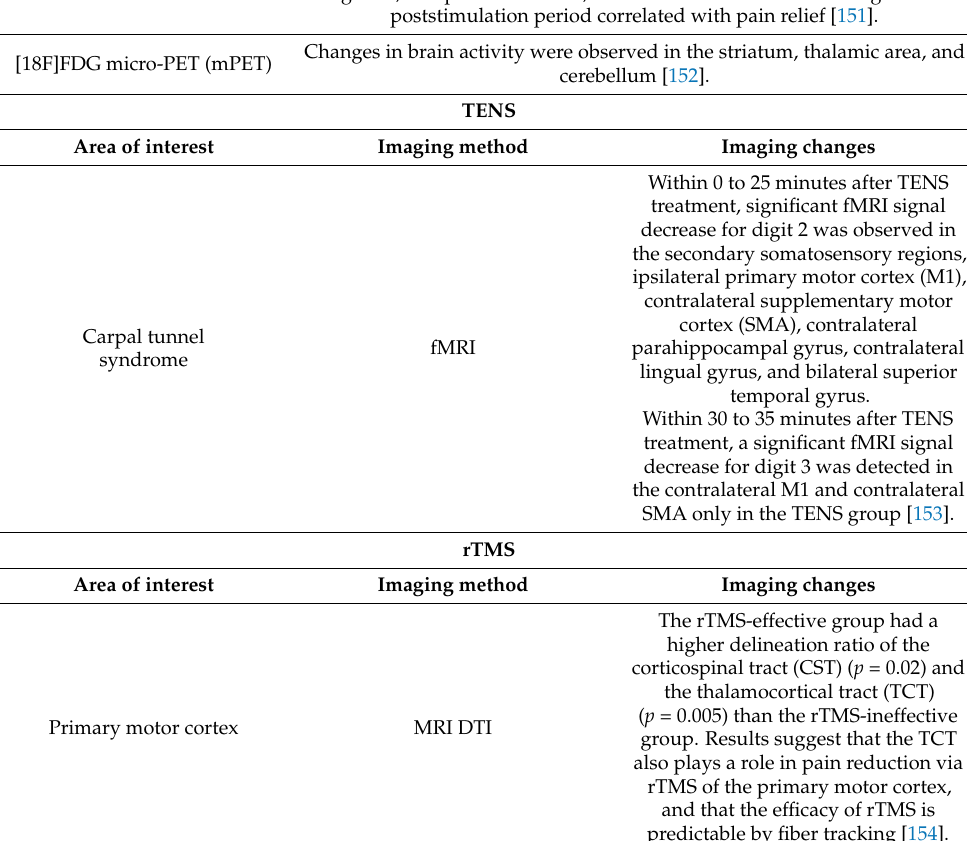
Table 2. Cont. Compared to baseline, turning on the stimulator was associated with CBF increase in the contralateral (anterior) midcingulate cortex (aMCC, BA24 and 32) and in the dorsolateral prefrontal (BA10) cortex. The most important changes in CBF were observed in the 75 min after discontinuation of MCS [15O]H2O PET (OFF). This poststimulation period was associated with CBF increases in a large set of cortical and subcortical regions (from posterior MCC (pMCC) to pregenual (pg) ACC, orbitofrontal cortex, putamen, thalami, posterior cingulate, and prefrontal areas, and in the brainstem. CBF changes in the poststimulation period correlated with pain relief